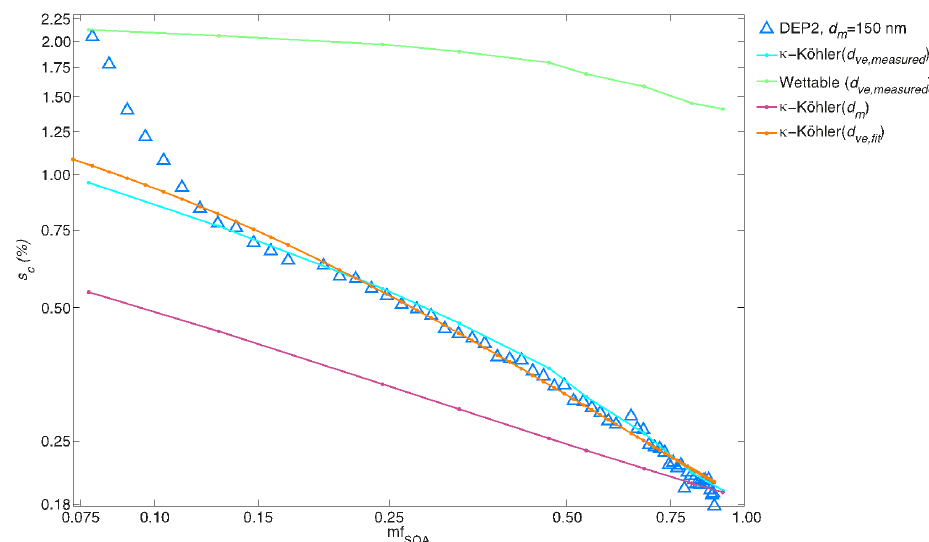
Figure 12. Empirical (blue triangles) vs. modelled (lines) results for experiment DEP2. Four different models are compared: (1) Wettable, taking only the Kelvin effect into account (i.e. i SOA = 0) and the dry diameter of the particle ( d s ) equals the measured volume-equivalent diameter ( d ve , measured ) ; (2) κ -Köhler( d m ) , accounts for the chemical composition but neglects the shape effect (i.e. d s equals the mobility diameter, d m ) ; (3) in κ -Köhler ( d ve , measured ) both the chemical composition and shape effects are accounted for, and d s = d ve , measured ; and (4) for the model κ -Köhler ( d ve , fit ) the particle diameter has been calculated by a fit function of d ve , measured and mf SOA (Eqs. 13, 14).